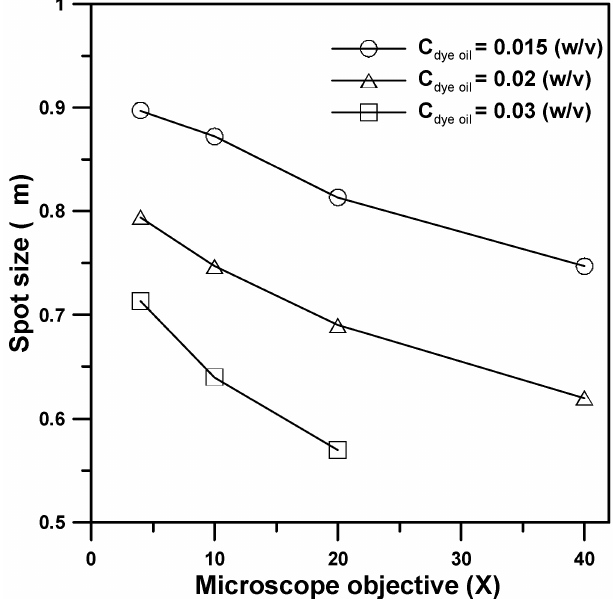
Figure 7. The focus spot size of the produced microlens structures with respect to the objective magnifications from 4× to 40× for the EFM-3D mask filled with the dye oil at C dye oil = 0.015, 0.02, and 0.03 ( w / v ) and operated without applied voltages,